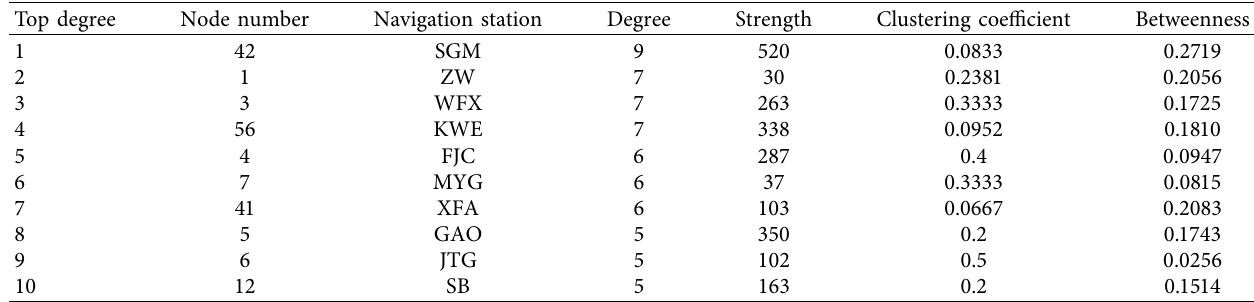
Table 3: Features of navigation stations with larger